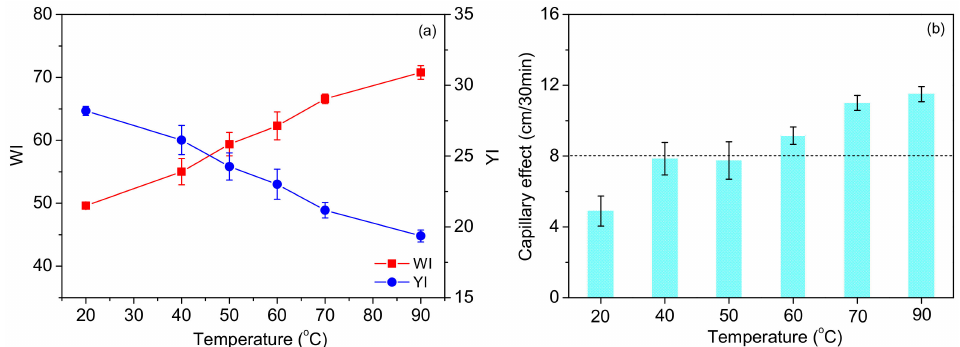
Figure 3. Effects of the temperature on the WI/YI ( a ) and capillary effect ( b ) of the fabrics.